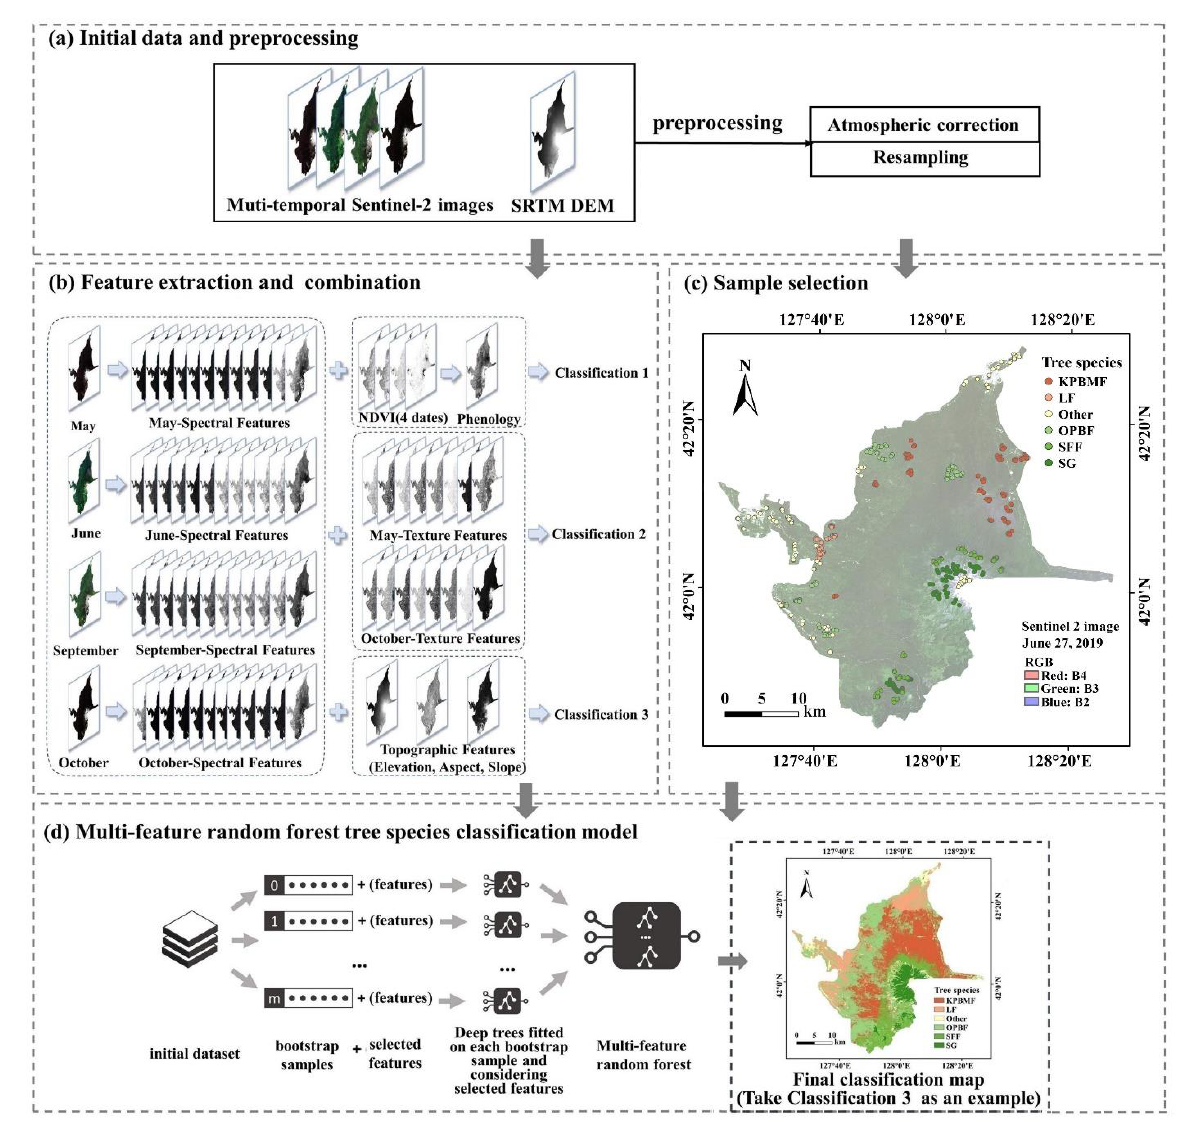
Figure 2. Flowchart of method in this